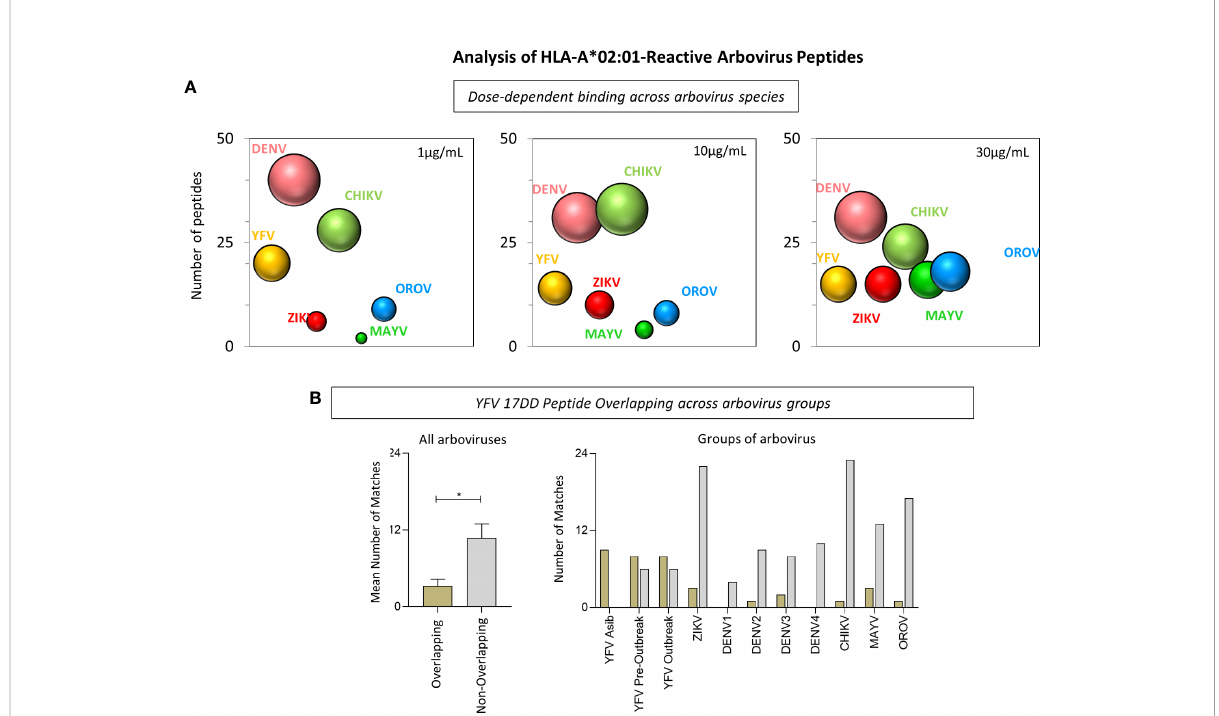
FIGURE 5 Analysis of HLA-A*02:01-Reactive Arbovirus Peptides. (A) Bubble size represents the number of HLA-A*02:01-reactive peptides at 1µg/mL, 10µg/mL and 30µg/mL of HLA-A*02:01 dimeric protein for each arbovirus included in this study. (B) Number of HLA-A*02:01-reactive peptides with and without overlapping YFV-17DD for all arboviruses (left) and for groups of arboviruses